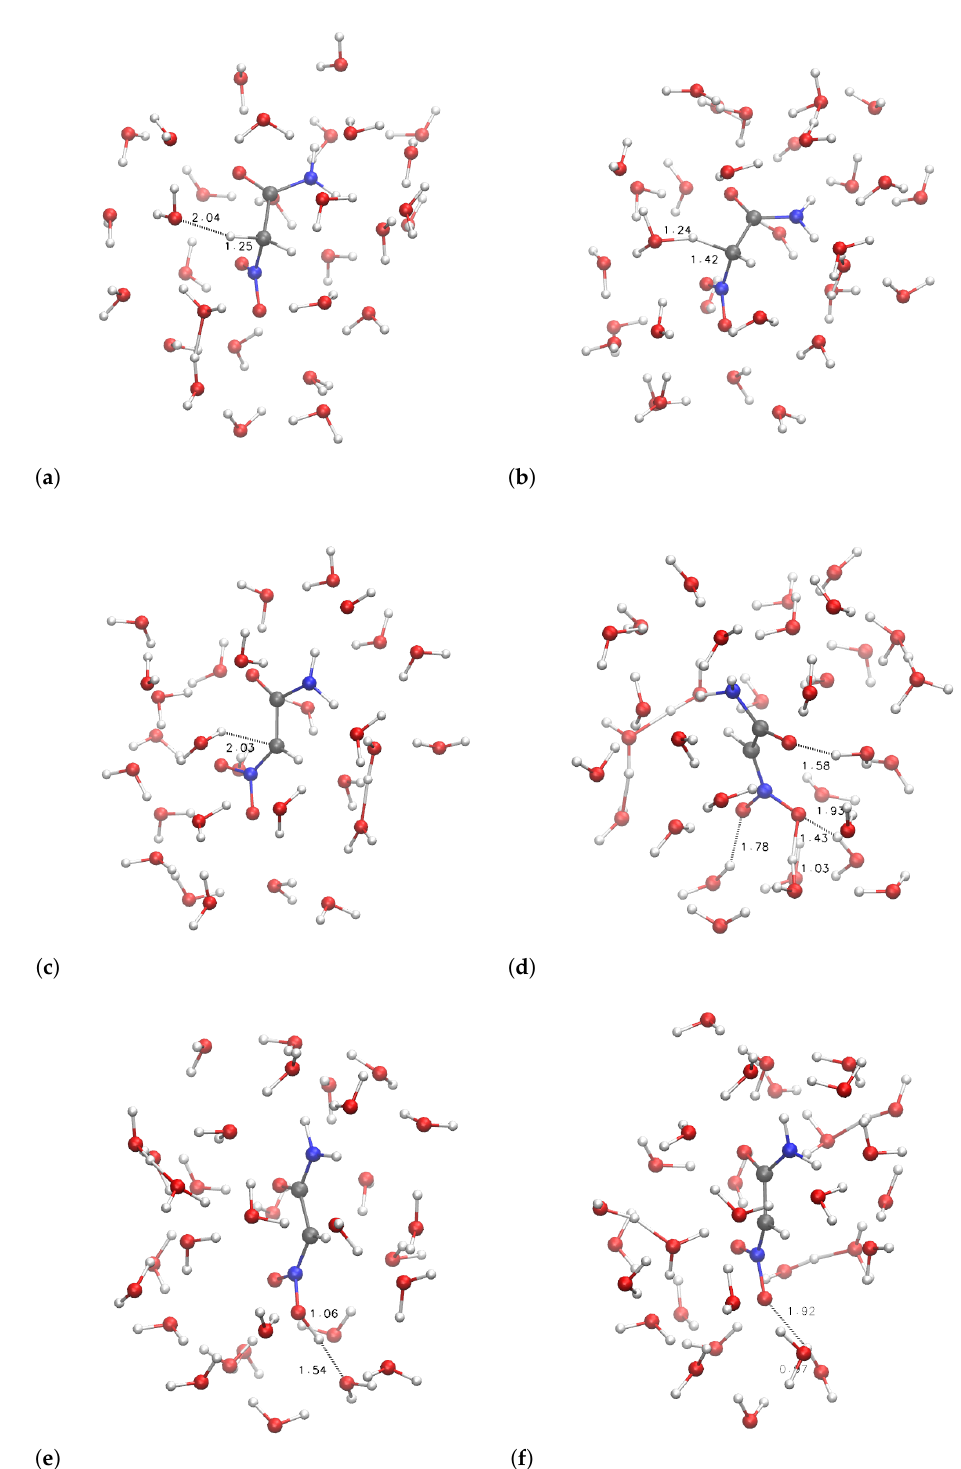
Figure 6. Structures of samples with R = H NCO along with proton extraction (Figure 5). Panels ( a – f ) 2 refer, respectively, to points indicated with a–f in Figure 5. C is gray, N is blue, O is red, H is white. Atomic and bond radii are arbitrary. Some relevant distances are displayed. Explicit bonds are drawn when atoms are closer than 1.6 Å. The VMD [31] program is used for all molecular